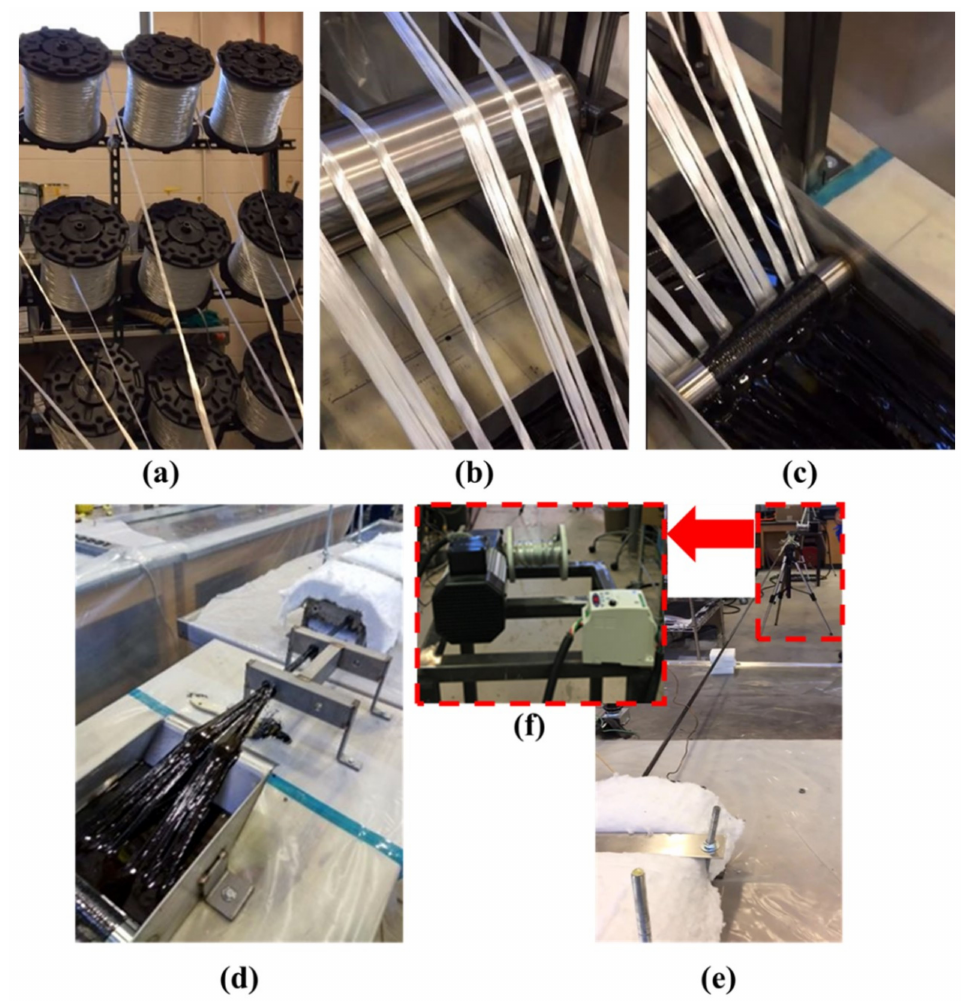
Figure 2. ( a ) Provision of fiberglass roving; ( b ) preforming; ( c ) open bath impregnation; ( d ) guiding and curing process in die; ( e ) take-o ff unit; ( f )